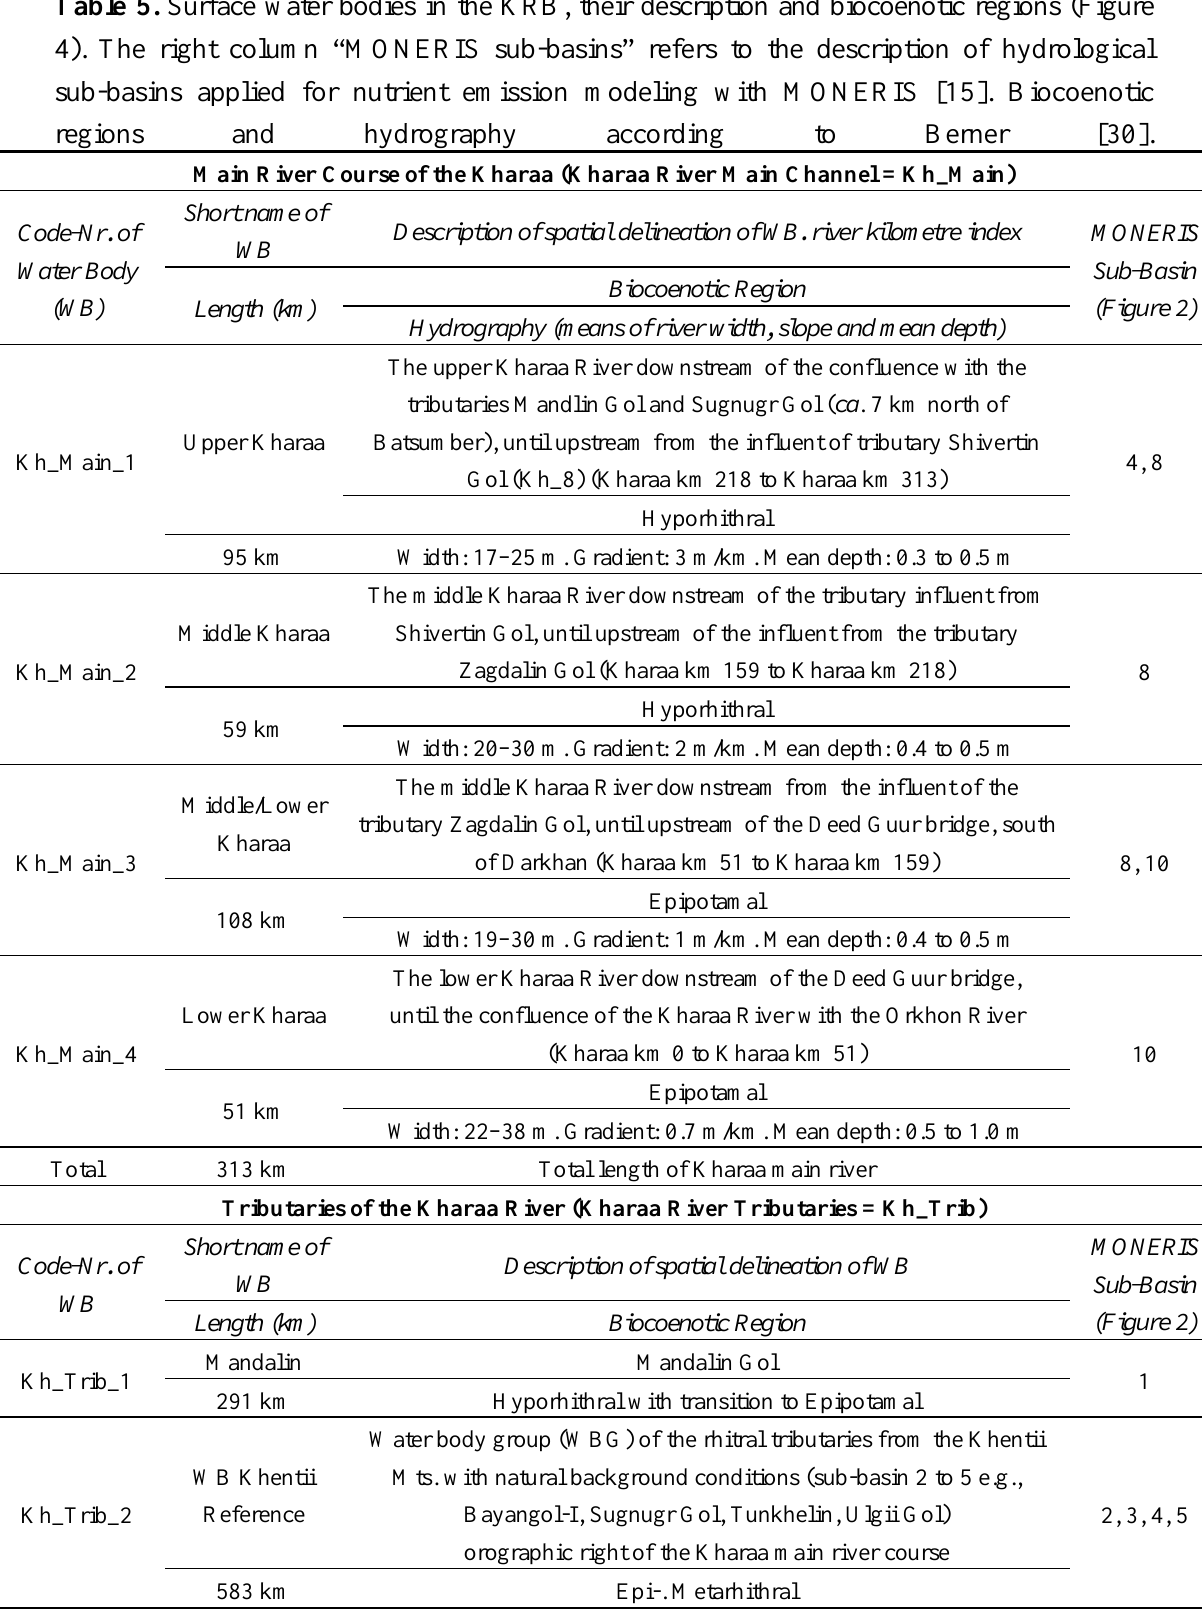
Table 5. Surface water bodies in the KRB, their description and biocoenotic regions (Figure 4). The right column “MONERIS sub-basins” refers to the description of hydrological sub-basins applied for nutrient emission modeling with MONERIS [15]. Biocoenotic regions and hydrography according to Berner